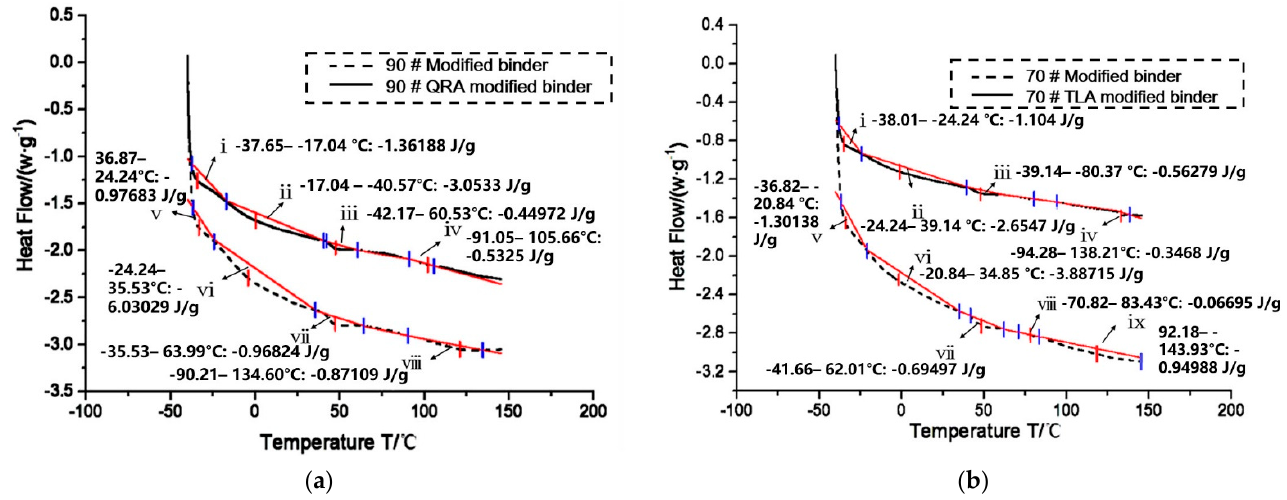
Figure 3. The DSC curve of ( a ) 90 # modified asphalt and 90 # QRA asphalt; ( b ) 70# modified asphalt and 70# TLA asphalt.